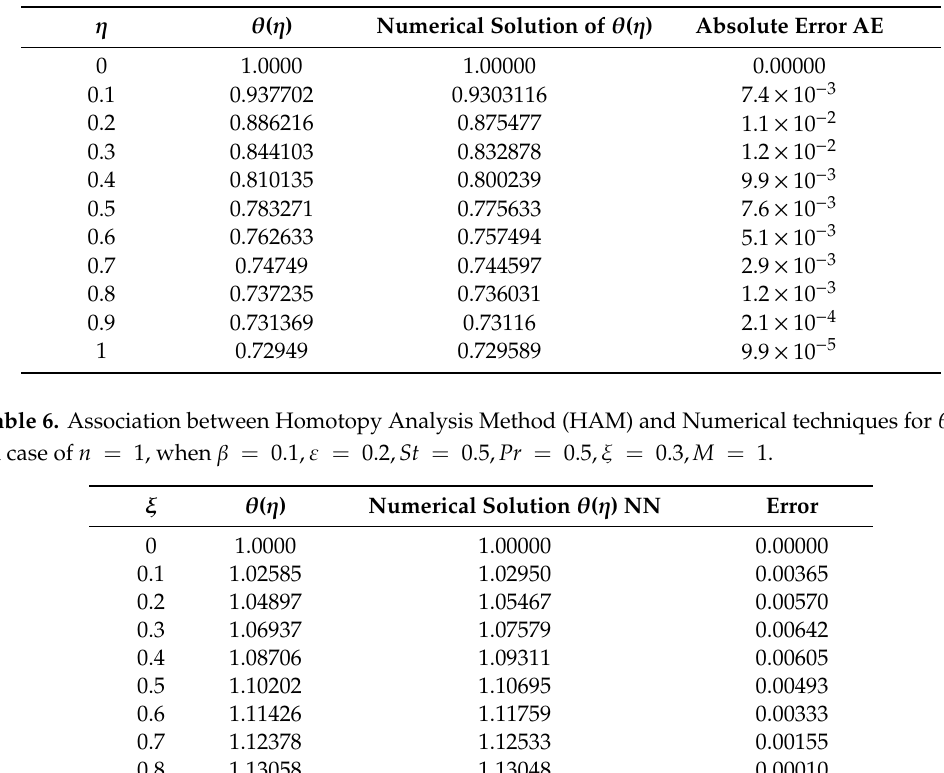
Table 5. Association between Homotopy Analysis Method (HAM) and Numerical techniques for θ ( η )